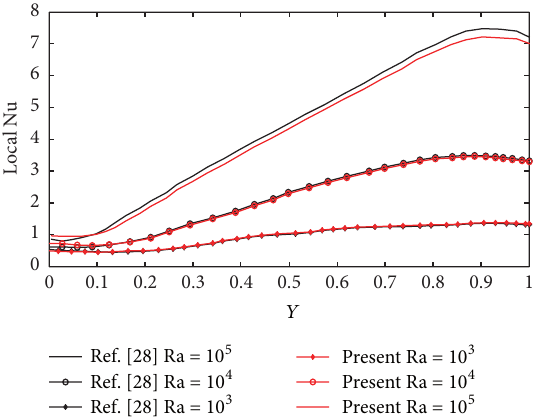
Figure 4: Comparison of spatial structure and variation of nusselt number along cold